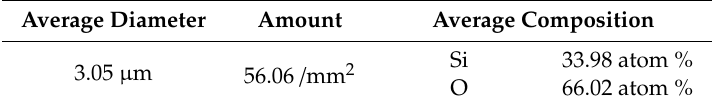
Table 5. The characteristic statistics of inclusions in the primary pure